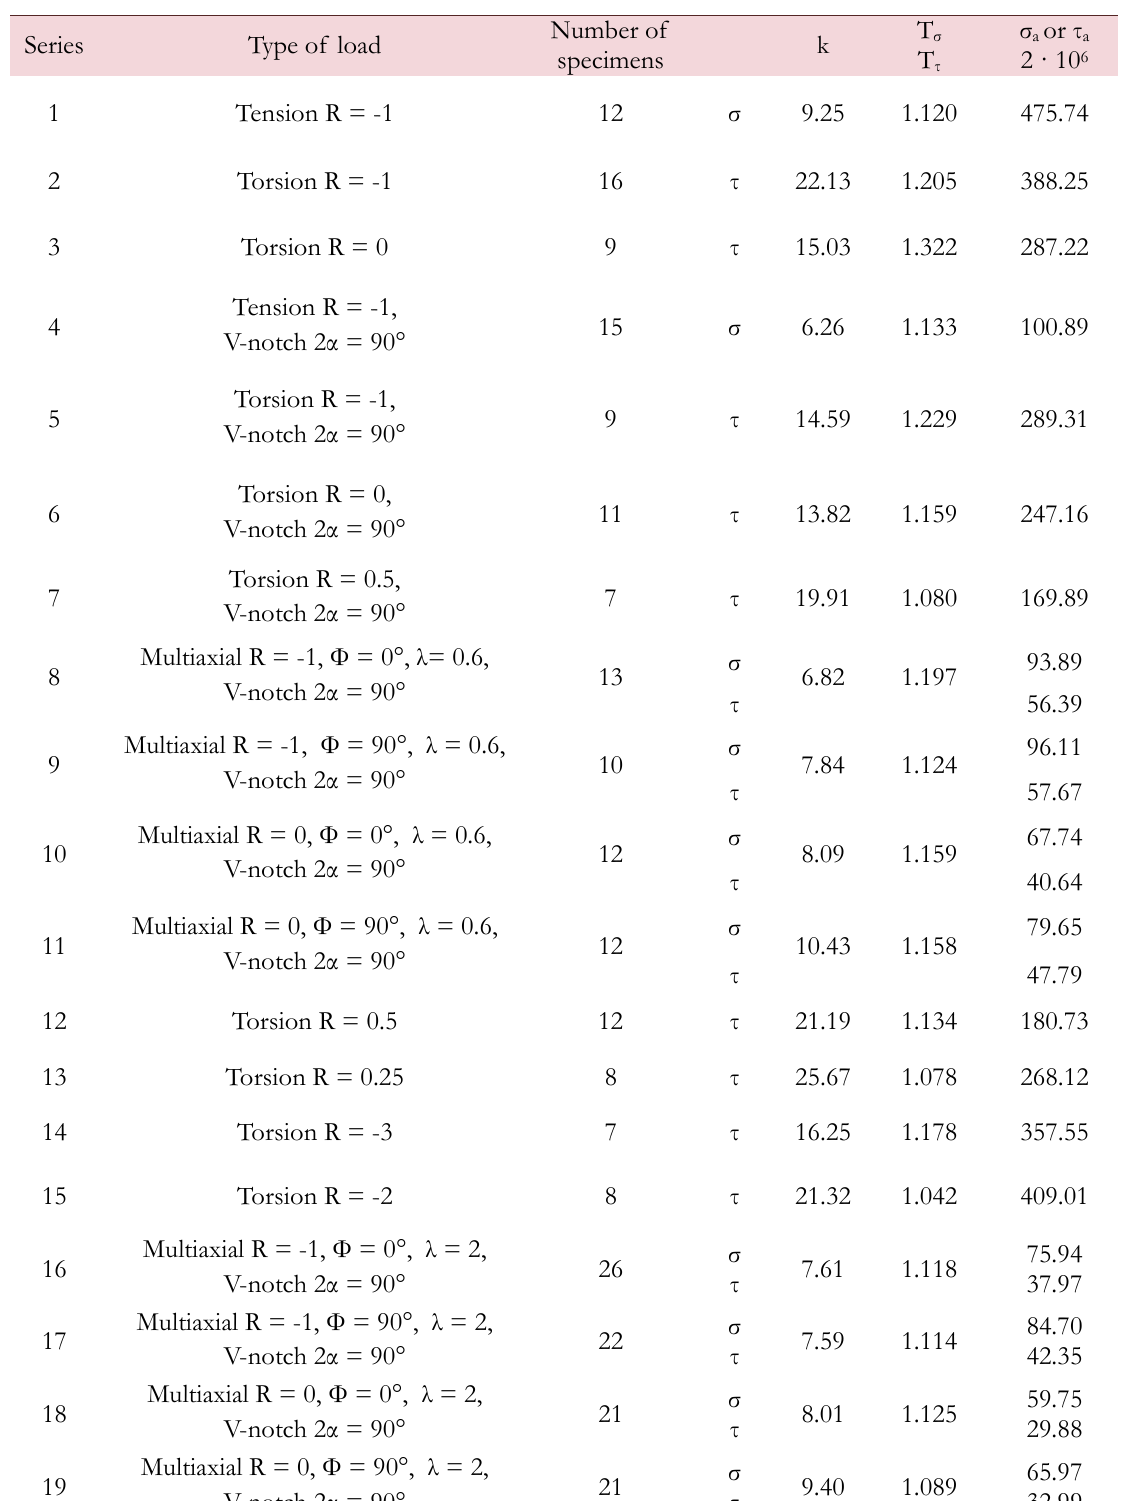
Table 1: Experimental results from fatigue tests. Mean values, P s = 50%. Stresses referred to the net